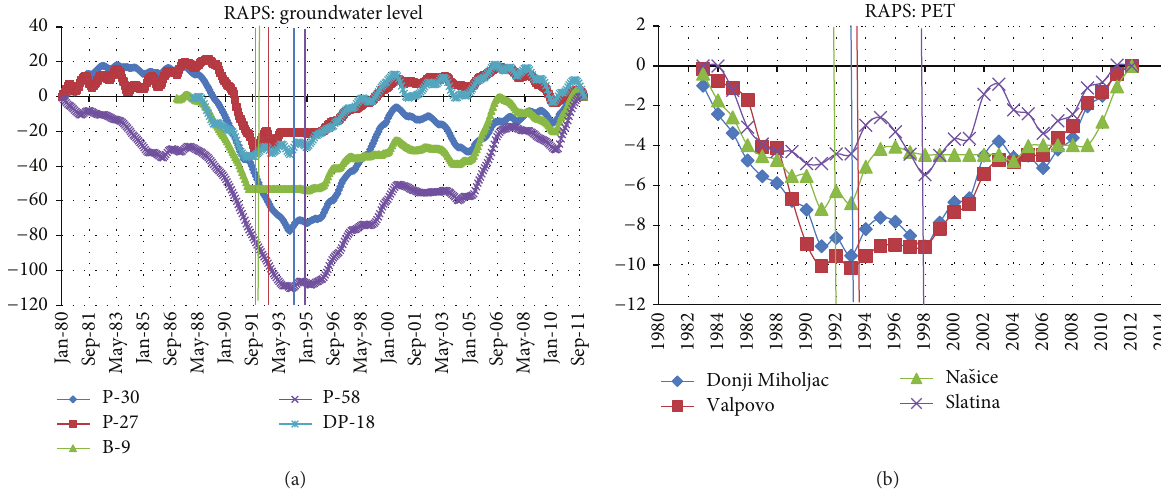
Figure 8: (a) RAPS of mean monthly groundwater levels and (b) RAPS of mean annual potential evapotranspiration.